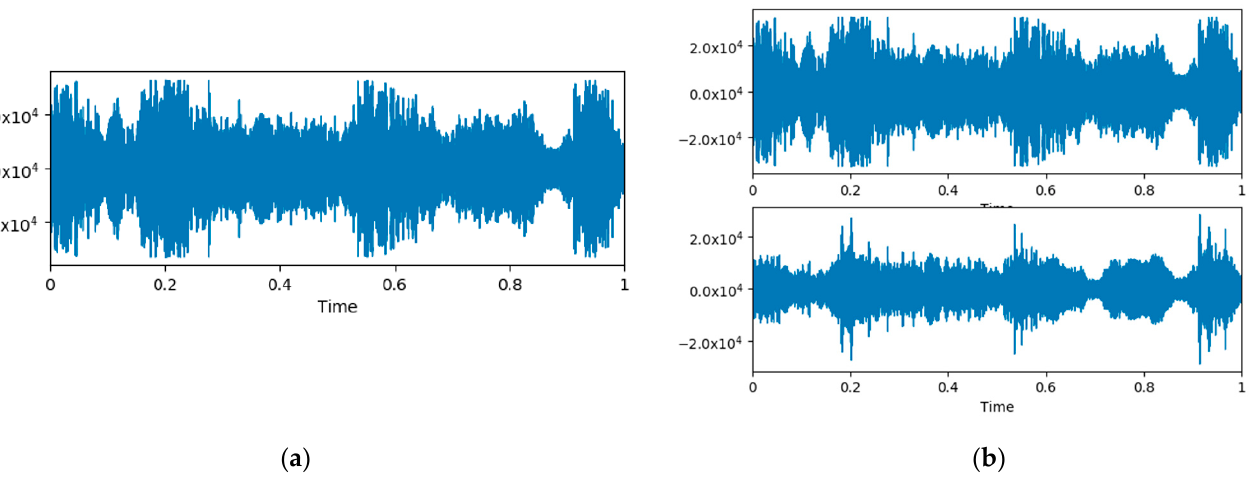
Figure 1. Audio waveforms. ( a ) Real mono audio; ( b ) fake stereo audio.